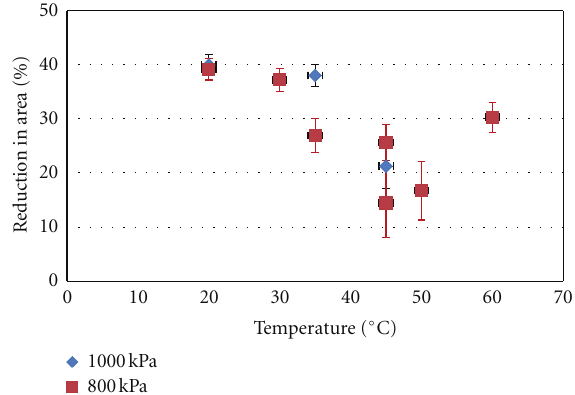
Figure 6: Comparison of two pressures over a temperature range with regard to reduction in area for a 25% CO and 75% CO 2 gas mixture. roughest and P1200 is the smoothest paper, and the average particle diameters are approximately 82, 75, 35, 26, 22,